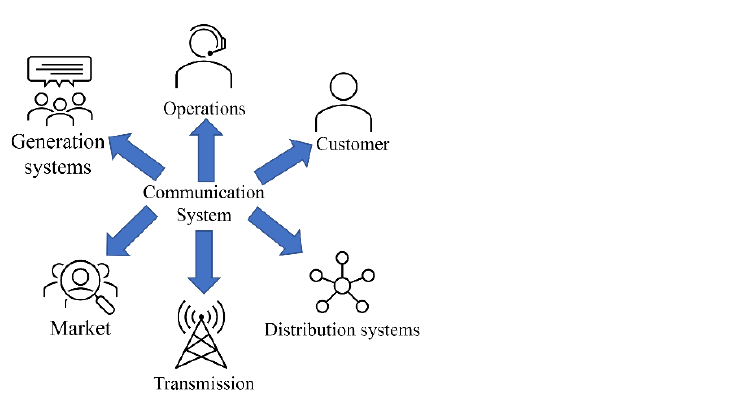
Figure 5. Modern multilevel communication microgrid.